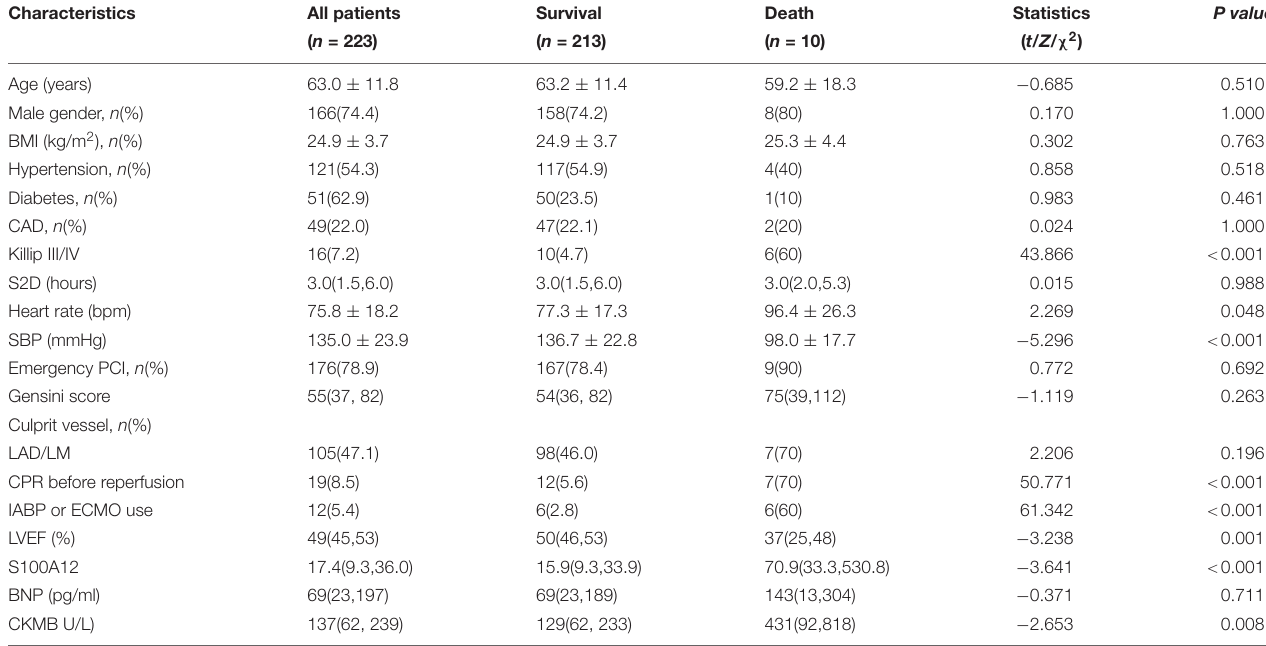
TABLE 2 | Univariate analysis of survival to discharge in our validated cohort. Characteristics All patients